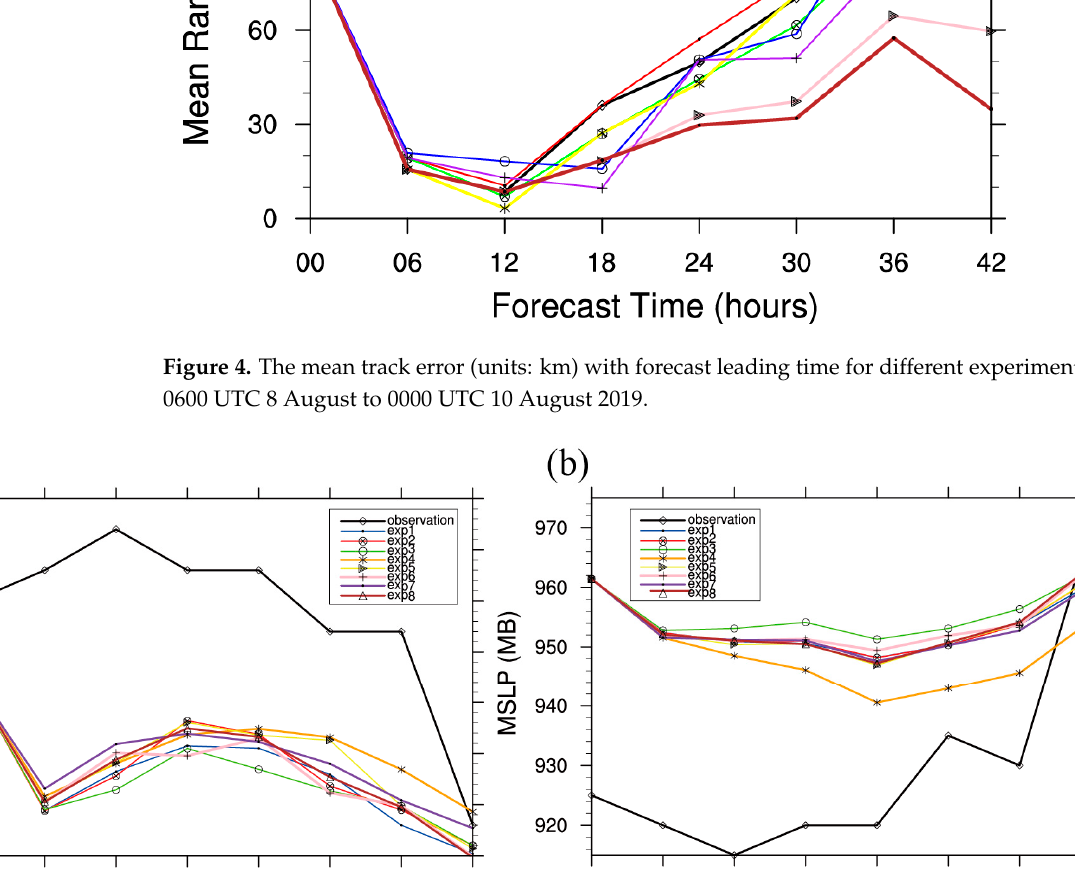
Figure 4. The mean track error (units: km) with forecast leading time for different experiments from 0600 UTC 8 August to 0000 UTC 10 August 2019.